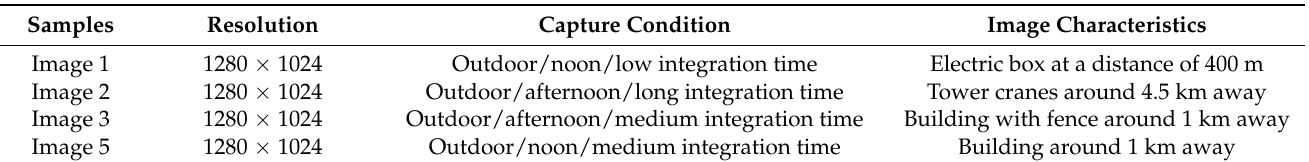
Figure 6. The SWIR camera used for data acquisition. ( a ) the SWIR camera, ( b ) outdoor experiments. Table 1. Summary of test images.